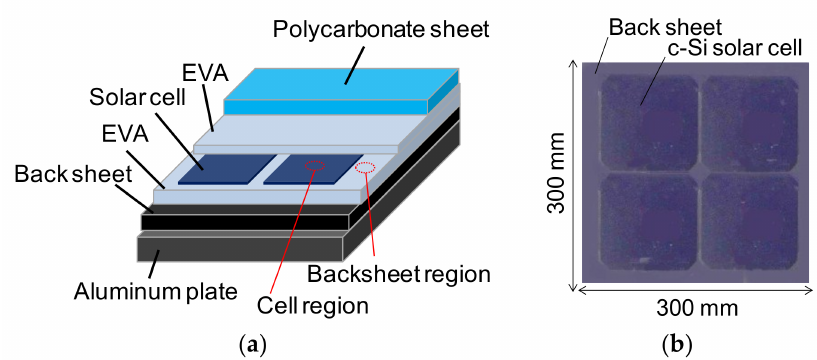
Figure 1. ( a ) Schematic of the c-Si solar module used in this study, which was originally developed for automotive application; and ( b ) Photo of the fabricated solar module with four solar